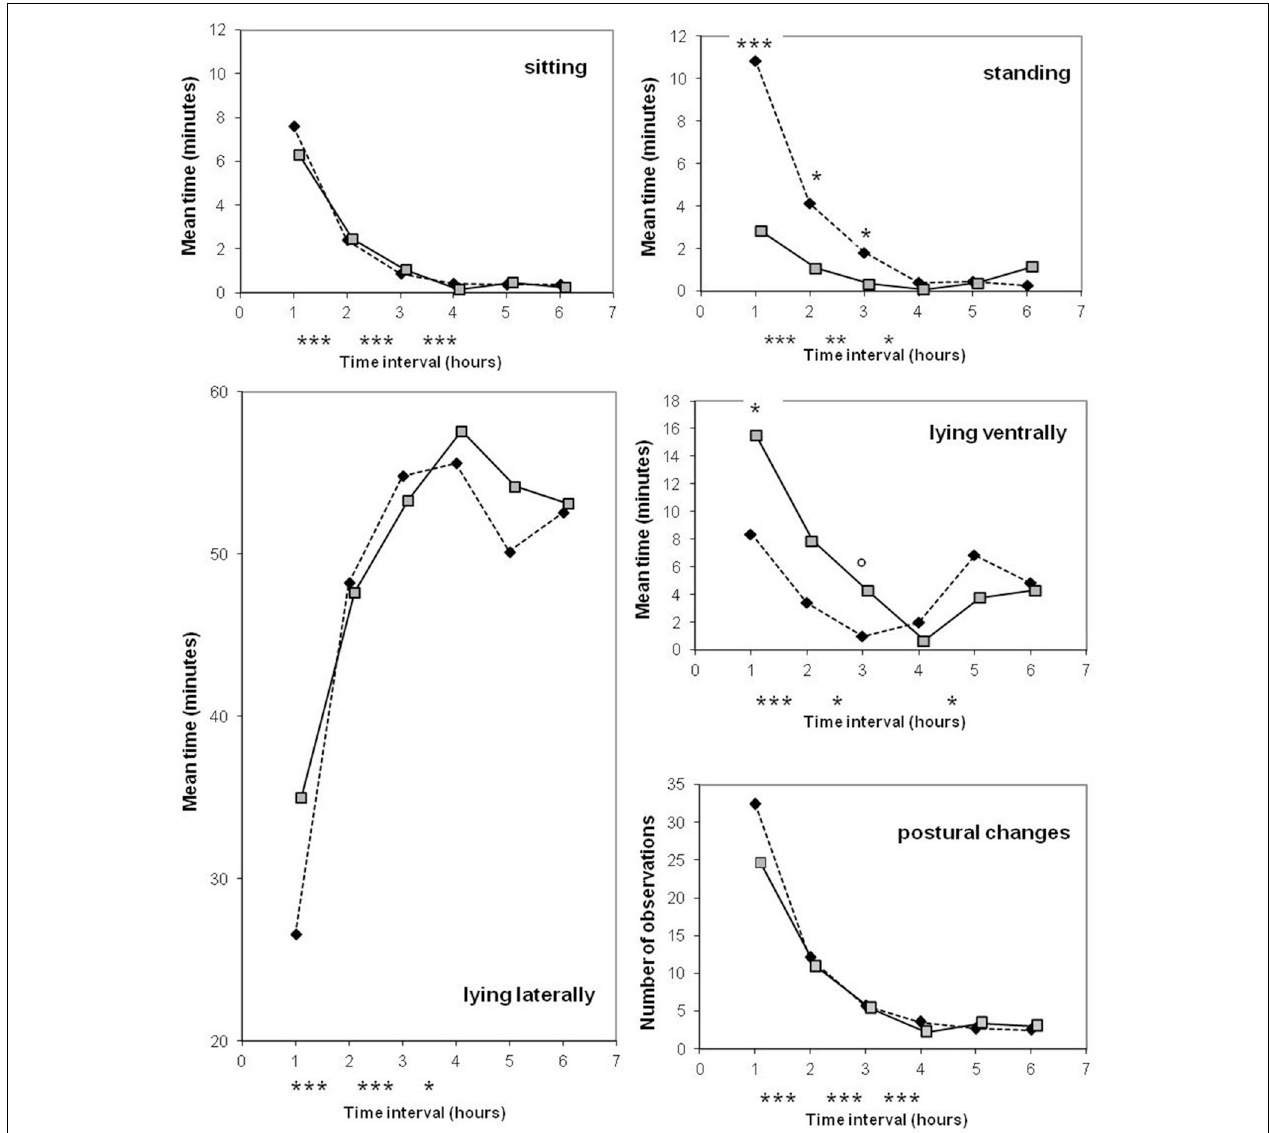
FIGURE 3 | Comparison of old-type sows ( (cid:2) ) and modern-type sows ( ) for postural activity during the first 6h after the onset of farrowing. Significance levels below the X axis refer to differences between successive